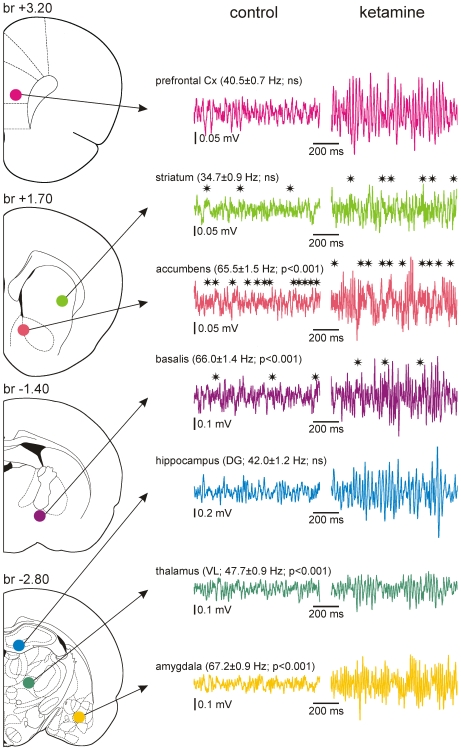
Ketamine increases the amount of ongoing γ oscillations in the prefrontal cortex and subcortical structures.Left panel: Schematic representation (modified from Paxinos and Watson, 1998) of the recording LFP sites. The location of the recording sites was proved following extracellular application of Neurobiotin made at the end of the recording session. The stereotaxic position of each coronal plane is given in mm relative to bregma (br). Right panel: 1-s episodes of LFP recorded (bandpass: 10–200 Hz) under fentanyl sedated state ∼15 min after subcutaneous injection of vehicle (saline, 1 ml/kg = control) then ∼15 min after injection of ketamine (5 mg/kg). Note that systemic injection of ketamine increases the amplitude of γ (30–80 Hz) oscillations in all recorded structures (1–2 subcortical sites recorded simultaneously with the frontoparietal surface ECoG). In the accumbens, basalis and striatum, the amount of high-frequency oscillations (81–160 Hz; asterisks) is also increased after ketamine injection. For each recording site, the average internal frequency of γ oscillation (±sem) is determined from 25 100-ms episodes. This frequency is compared with that measured in the corresponding frontoparietal ECoG (Student t test; ns, non-significant). The internal frequency of γ oscillations recorded in the frontoparietal cortex varies from 30 to 50 Hz (40.2±0.7 Hz). The measured average frequencies do not include high-frequency oscillations that were recorded especially in the accumbens, basalis and striatum (asterisks). Cx, cortex; DG, dendate gyrus; VL, ventral lateral.